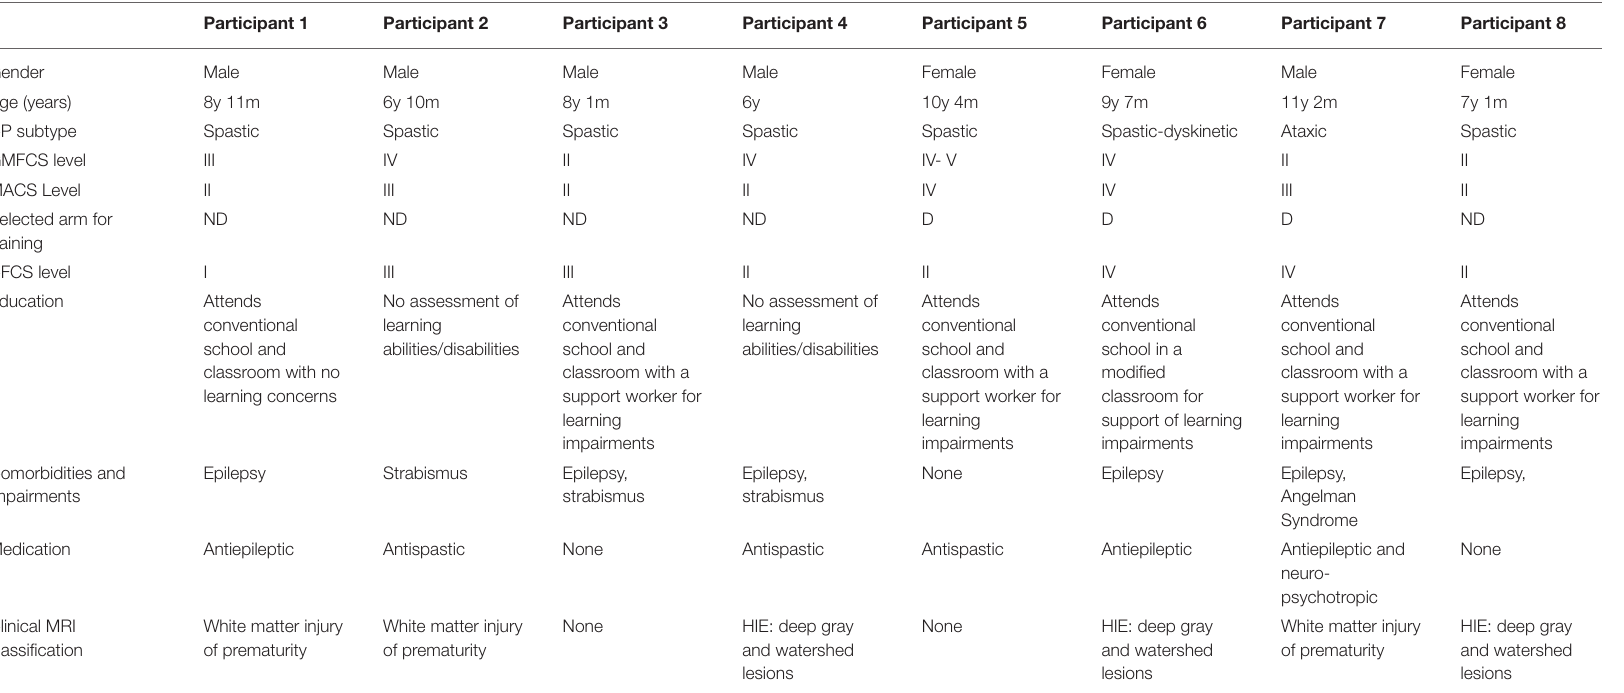
TABLE 1 | Participant demographics and baseline